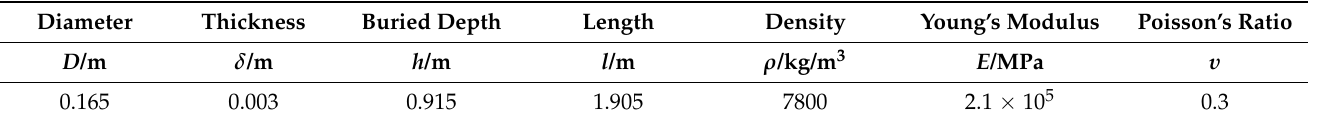
Table 4. Parameters of the model pile.